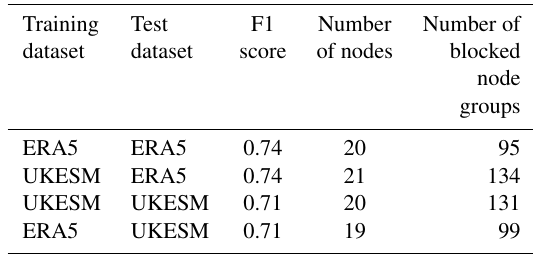
Table 2. A comparison of the optimal F1 score for when Z 500 ERA5 and UKESM datasets are trained and tested on themselves and each other respectively. The corresponding node number and number of blocked node groups is shown. When the dataset is tested on itself, 10-fold cross-validation is used and the mean value is shown. The optimal F1 score is identified by finding the node num- ber with the smallest difference between precision and recall whilst maintaining a relatively high F1